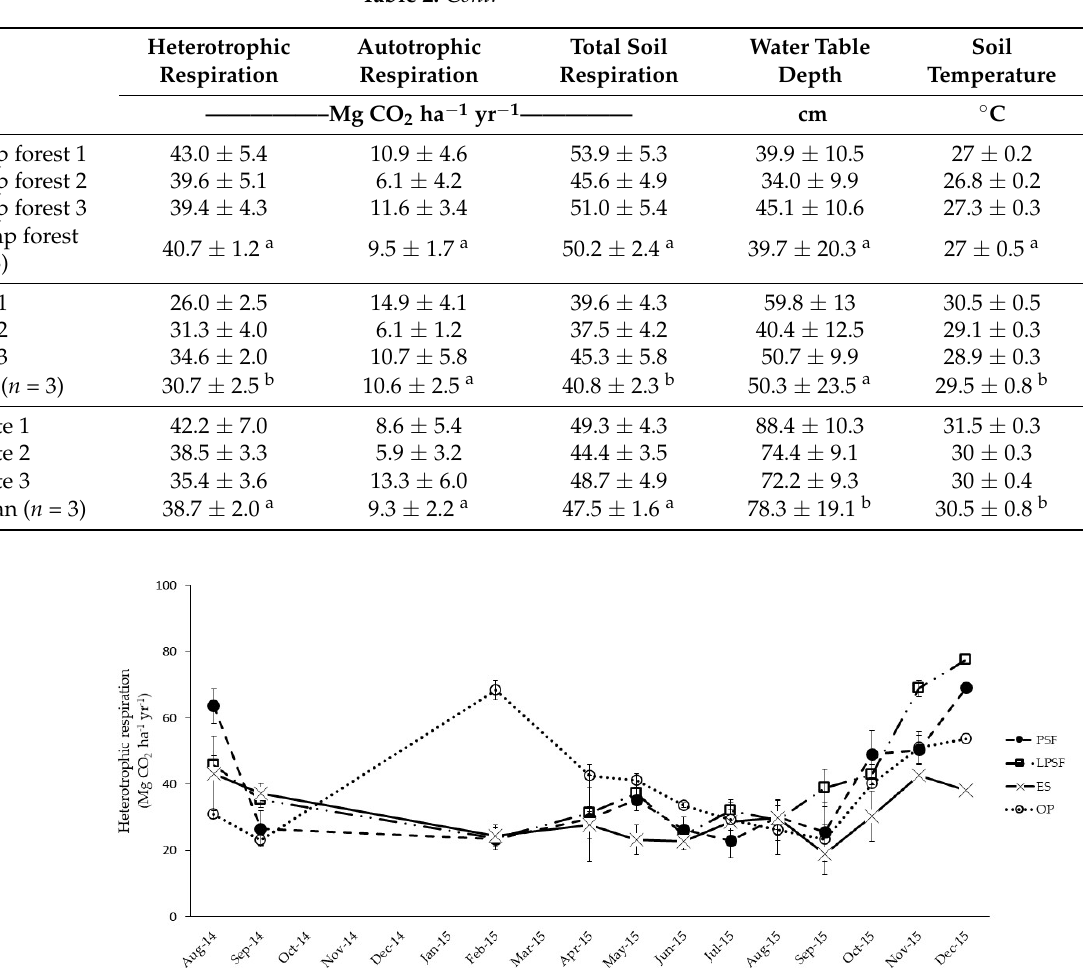
Figure 3. Heterotrophic respiration trend from August 2014 to December 2015 in PSF (black circle), LPSF (square hollow), ES (cross), and OP (hollow circle). Dry months are represented by data from August, September, and October (5 months). Wet months are represented by data from February to July and November to December (7 months). Error bars show ± standard error (SE) of the heterotrophic respiration data.